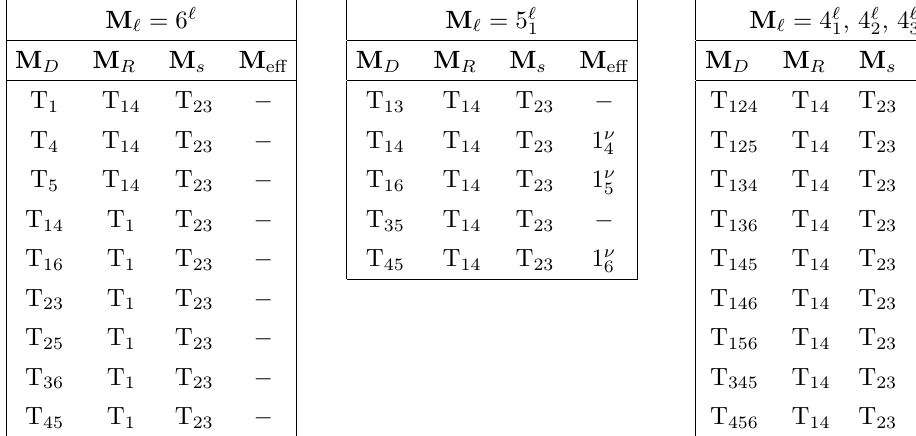
Table 2 . Maximally-restrictive texture sets for M ‘ = 6 ‘ (left), 5 ‘